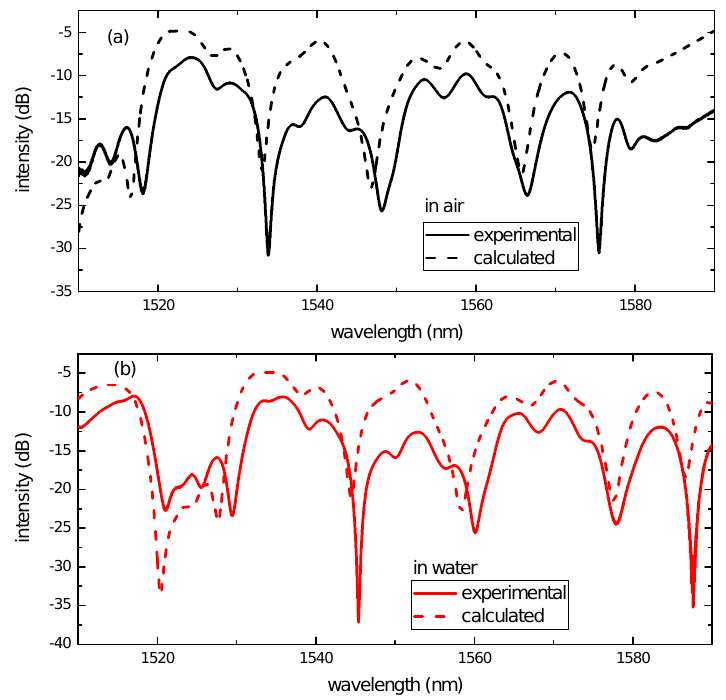
Figure 7. The simulated and experimental transmission spectra of the SNCS structure with a NCF = 62.5 µ m and z NCF = 127mm ( a ) in air; ( b ) in